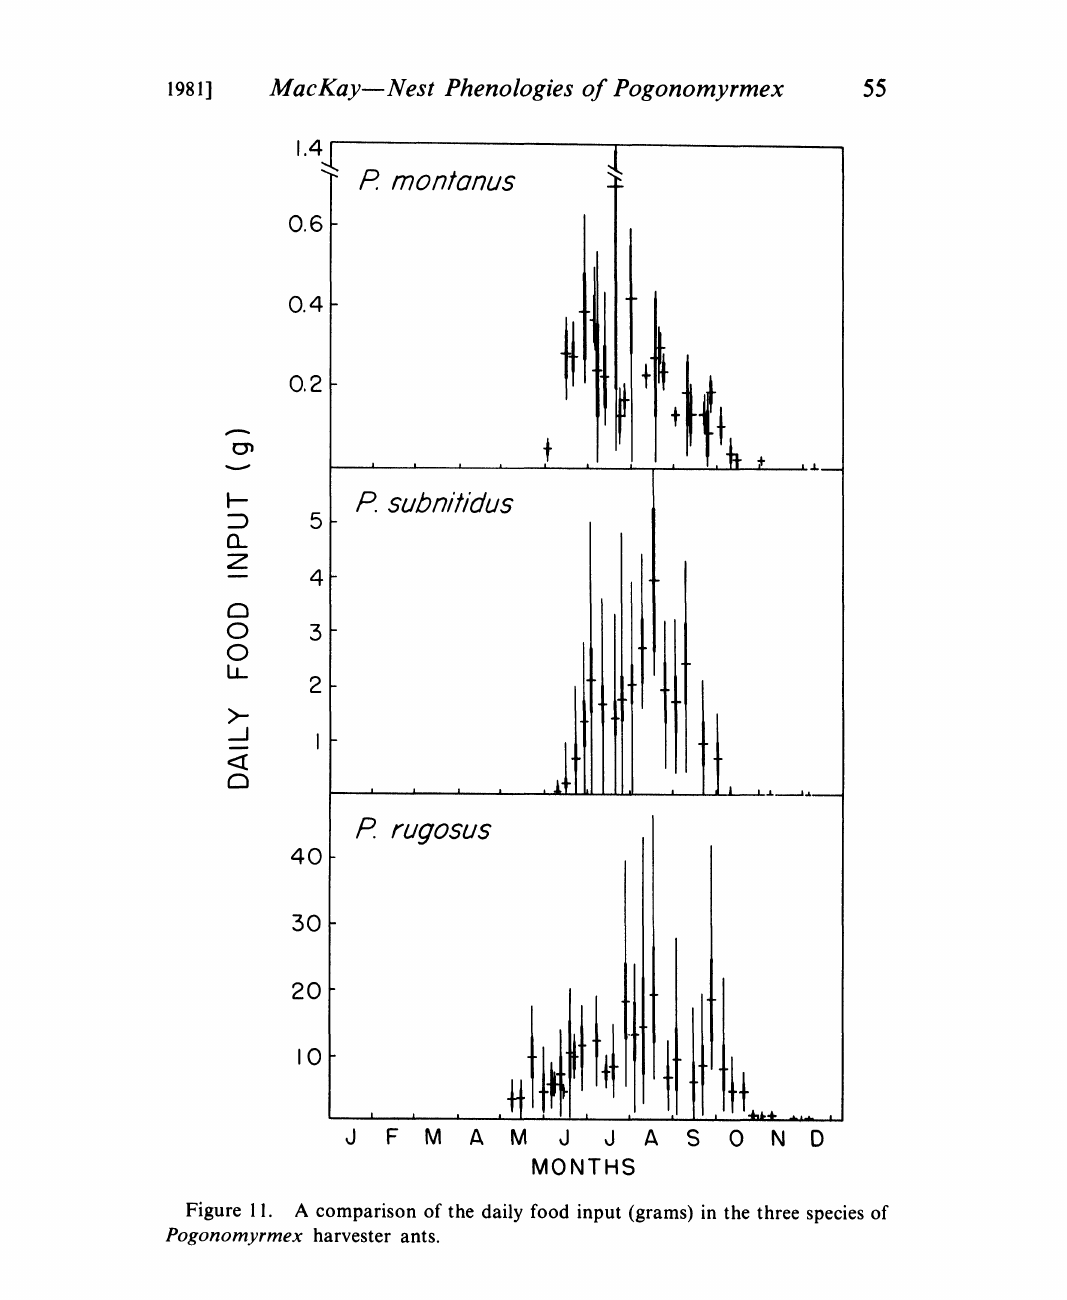
Figure 11. A comparison of the daily food input (grams) in the three species of Pogonomyrmex harvester